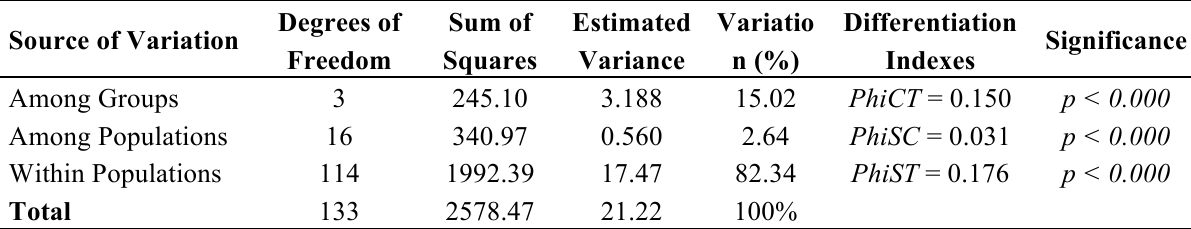
Table 5. Spatial analysis of molecular variance of Jatropha curcas collected in Chiapas, Mexico.